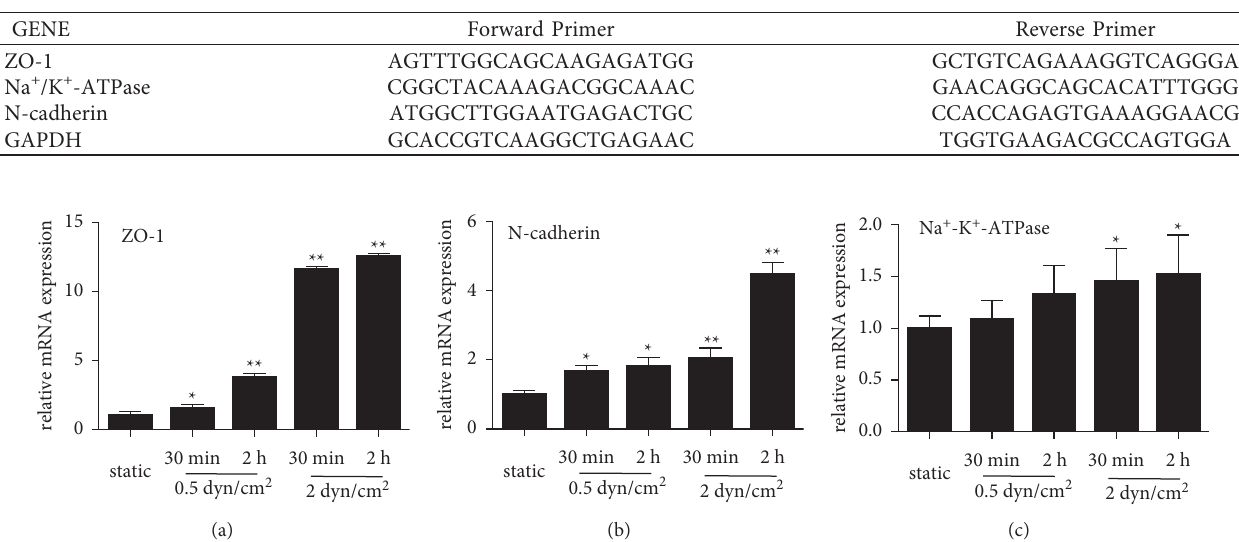
Figure 2: Effect of shear stress on the mRNA expression of corneal endothelial cell-related markers. (a) ZO-1 mRNA expression was significantly increased after treatment with shear stress (0.5dyn/cm 2 and 2dyn/cm 2 ) for 30min and 2h. (b) N-cadherin mRNA expression gradually increased as the shear stress intensity increased compared with the static control. (c) Na + -K + -ATPase mRNA expression was slightly increased after exposure to shear stress. The data are presented as the mean ± SD; ∗ P < 0 . 05, ∗∗ P < 0 . 01.